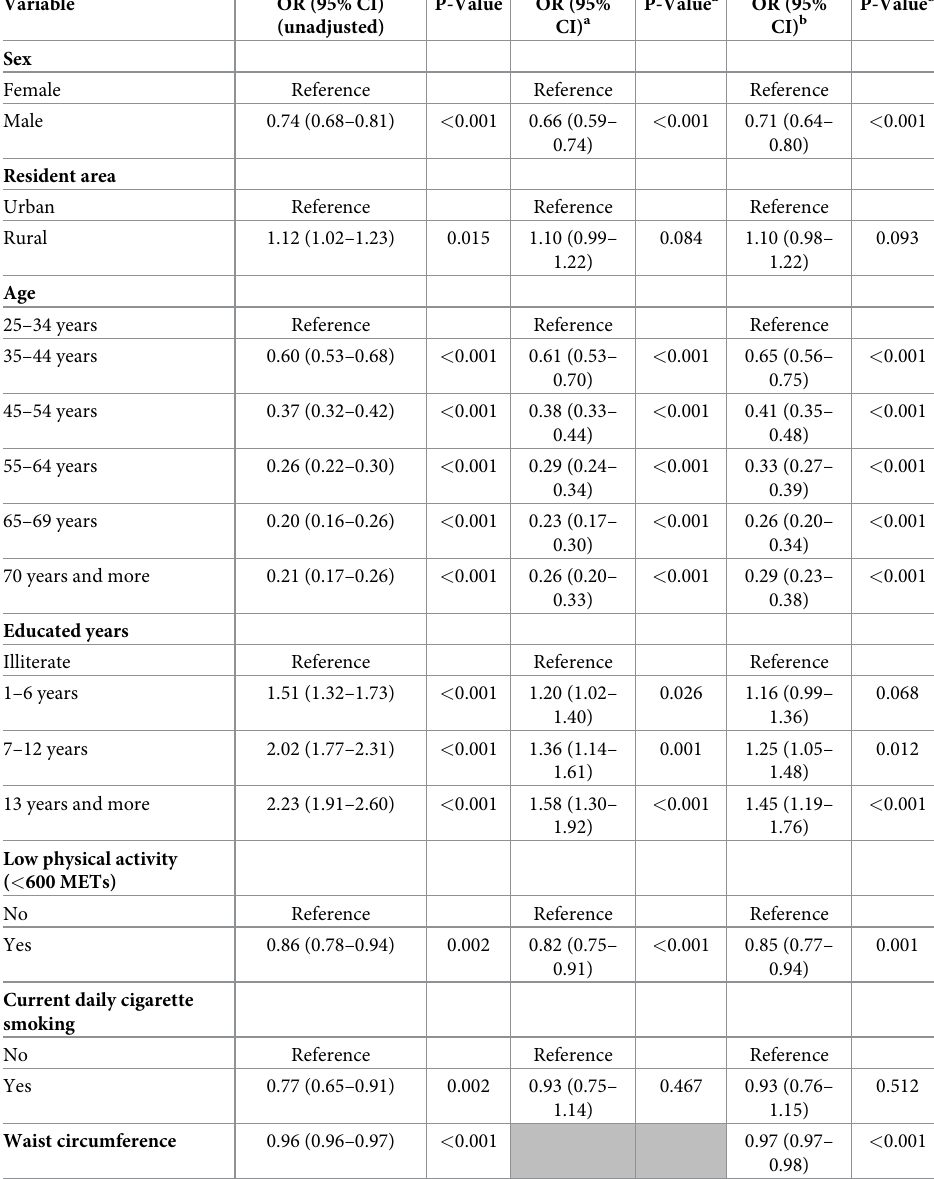
Table 4. Logistic regression model showing risk factors of metabolically healthy phenotype among overweight and obese individuals. Variable